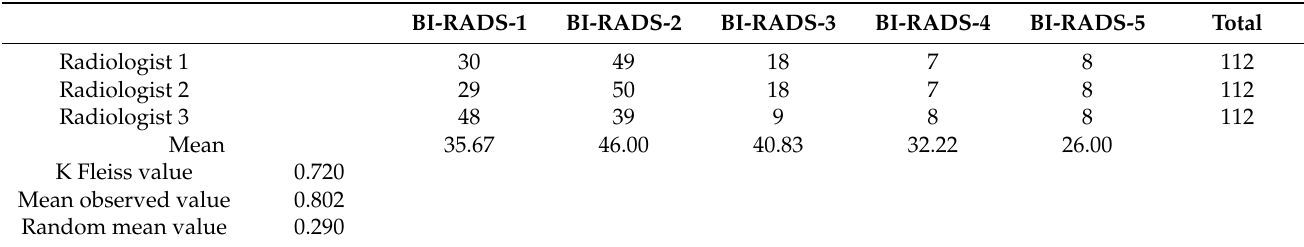
Table 5. Radiologists’ (N. 3) BI-RADS assessment of